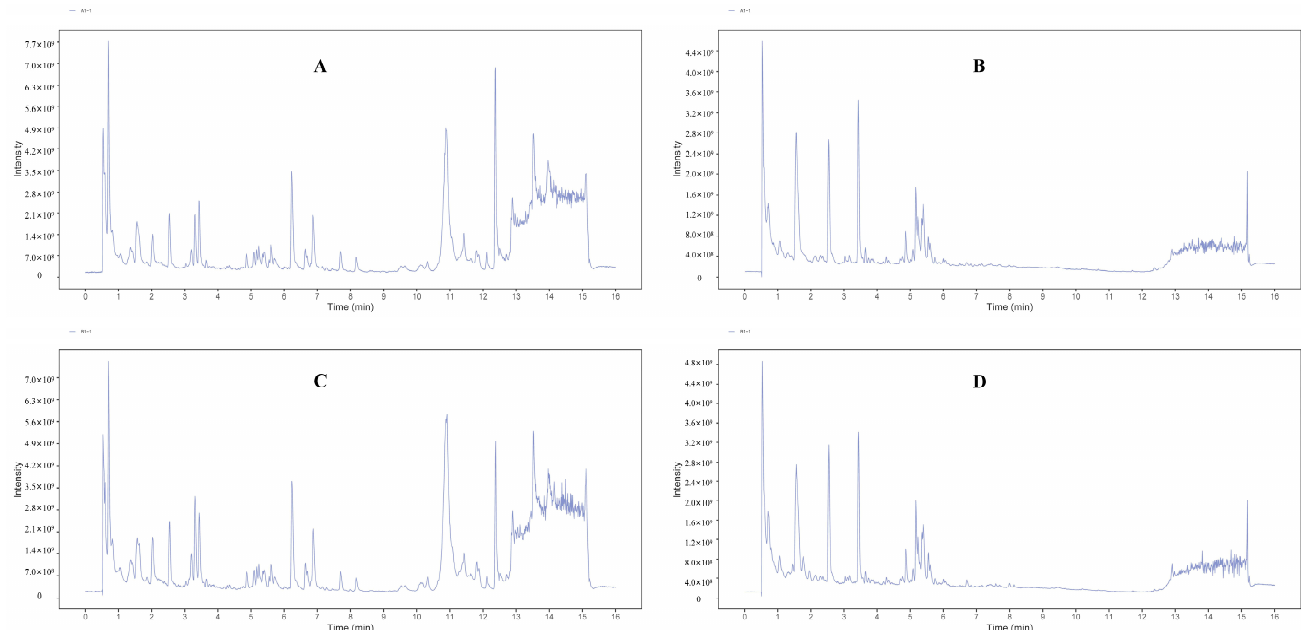
Figure 1. Total Ion Flow Diagrams of SHL and SHLF Samples. ( A ) Positive ion mode of SHL; ( B ) Negative ion mode of SHL; ( C ) Positive ion mode of SHLF; ( D ) Negative ion mode of SHLF.